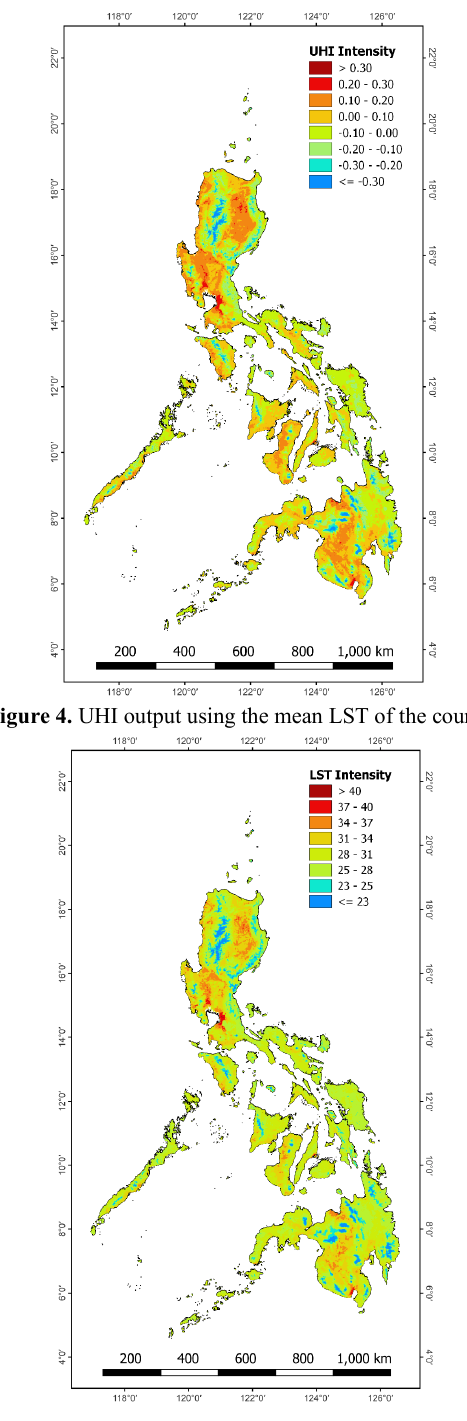
Figure 5. Spatial distribution of mean LST in the country in